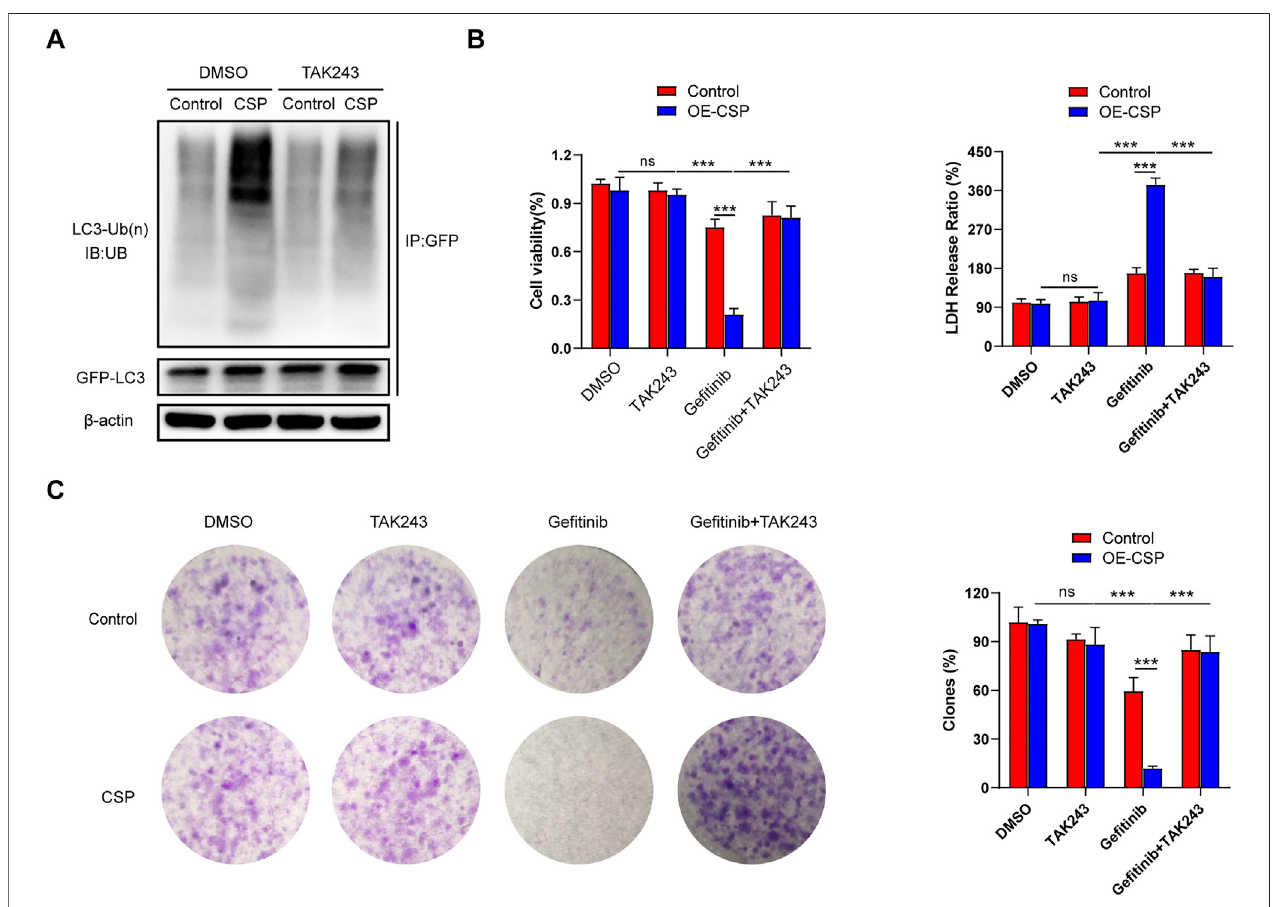
FIGURE 7 | Ubiquitin inhibition by TAK-243 rescues the sensitizing effect of CSP on ge fi tinib. (A) Control and OE-CSP A549 cells (1 × 10 6 ) were transfected with GFP-LC3B plasmid and then treated with TAK-243 and MG132 for 24 h. The GFP-LC3B was puri fi ed and the level of ubiquitin was detected by Western blotting. Cell viability after treatment with TAK-243 and ge fi tinib was examined by (B) a CCK8 kit ( left ) and LDH assay ( right ). (C) Cell colony formation ability and (D) apoptosis were also assessed using the method described above. The clone rate (%) was normalized to the control group (DMSO). Representative images for colony analysis and fl ow cytometry ( left ) and statistical histograms ( right ). Viable, early apoptotic cells; non-viable, late apoptotic cells. (E) Nude mice were then treated with TAK-243 plus ge fi tinibwhenthetumorvolumewasapproaching100 mm 3 .Experimentswererepeatedtwotimeswiththreemicepergroupperexperiment.Thedataarepresentedas the mean ± standard deviation of three independent experiments in vitro (ns, not statistically signi fi cant, ** p < 0.01, *** p < 0.001).